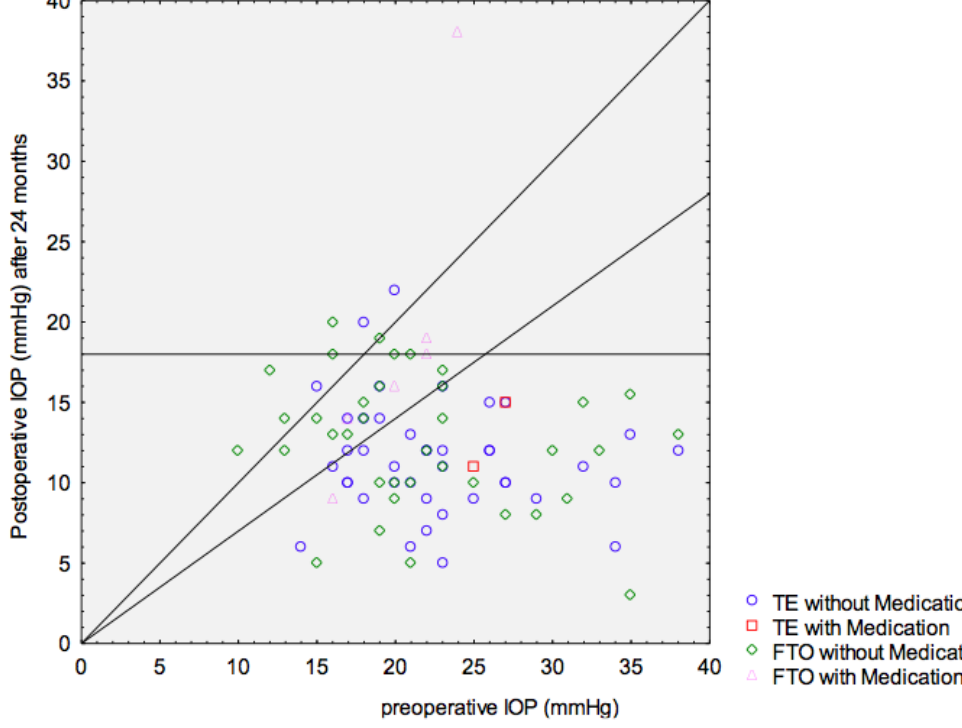
Figure 7. Scatter plots of IOP of both groups. Few patients required medications postoperatively.